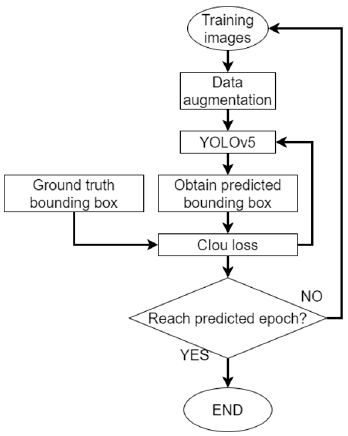
Figure 6. Training flow chart of YOLOv5.